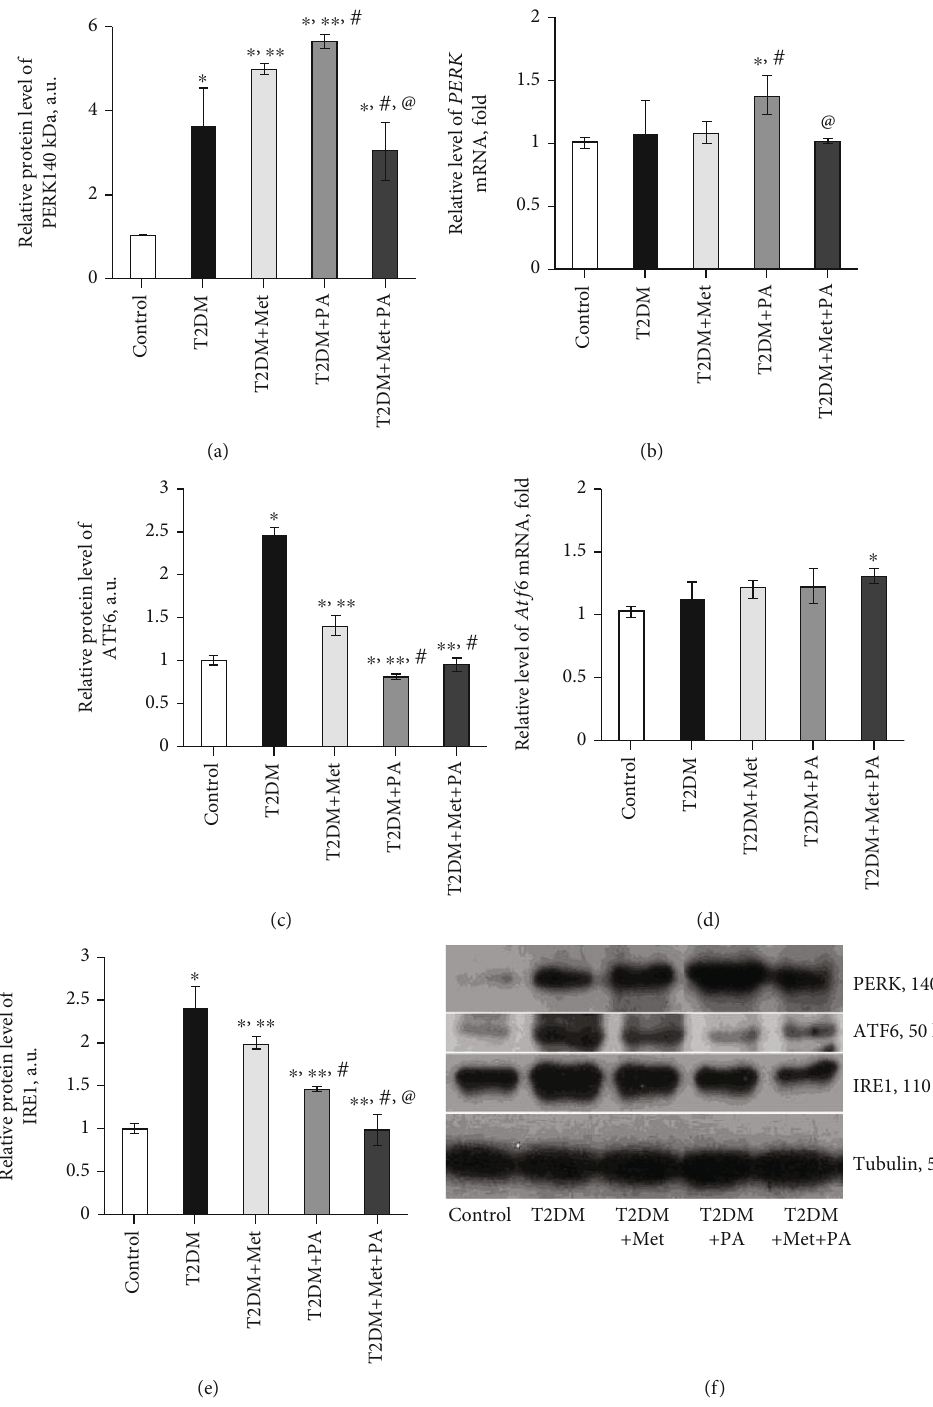
Figure 7: E ff ects of administration of metformin and PA on the major components of unfolded protein response system — PERK, ATF6, and IRE1. Immunoblotting analysis of PERK, ATF6, and IRE1 in rat VMH: the bar graphs of (a) PERK, (c) ATF6, and (e) IRE1 protein content are presented; (f) representative immunoblots are shown, and data are quanti fi ed using tubulin as a loading control for hypothalamus lysates. Quantitative RT-PCR of (b) Perk and (d) Atf6 in rat VMH: data were normalized to β -actin and pooled from three independent experiments ( n = 6 rats/group). All data are shown as means ± SEM ; ∗ p < 0 : 05 vs. control, ∗∗ p < 0 : 05 vs. T2DM, # p < 0 : 05 vs. metformin administration, and @ p < 0 : 05 vs. PA